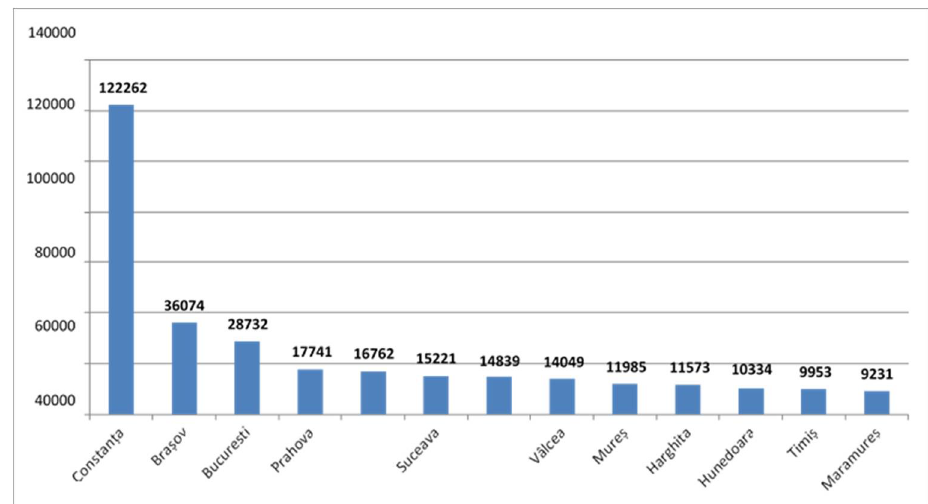
Figure 4. Number of accommodations, by county (December 2018). Source http://turism.gov.ro/web/autorizare-turism/, accessed on 20 April 2021.